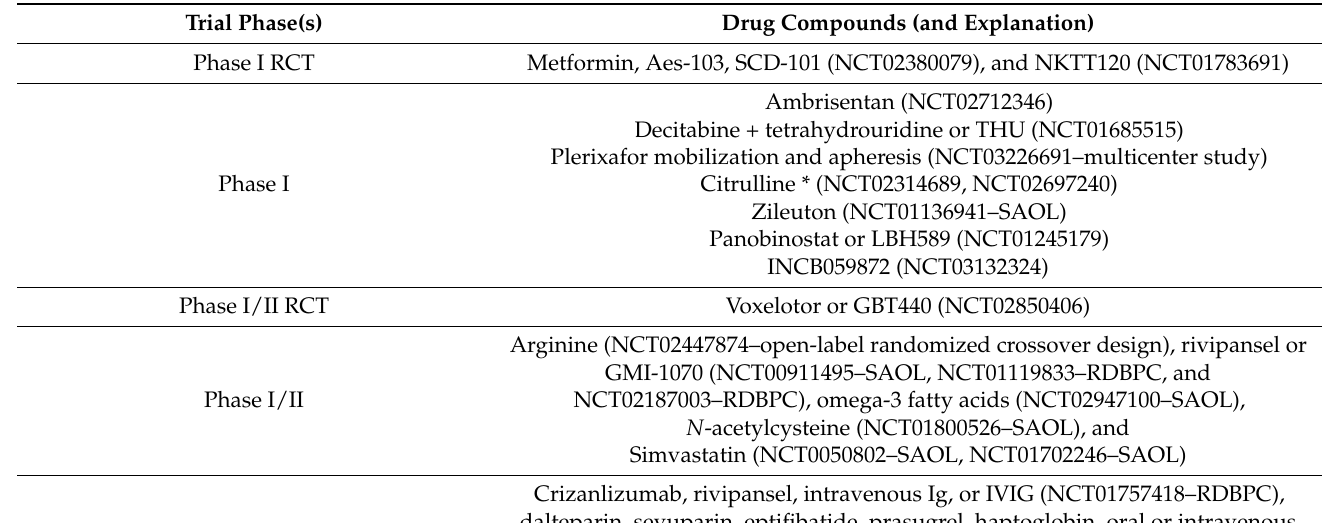
Table 1. Current clinical trials for sickle cell disease (SCD) treatments